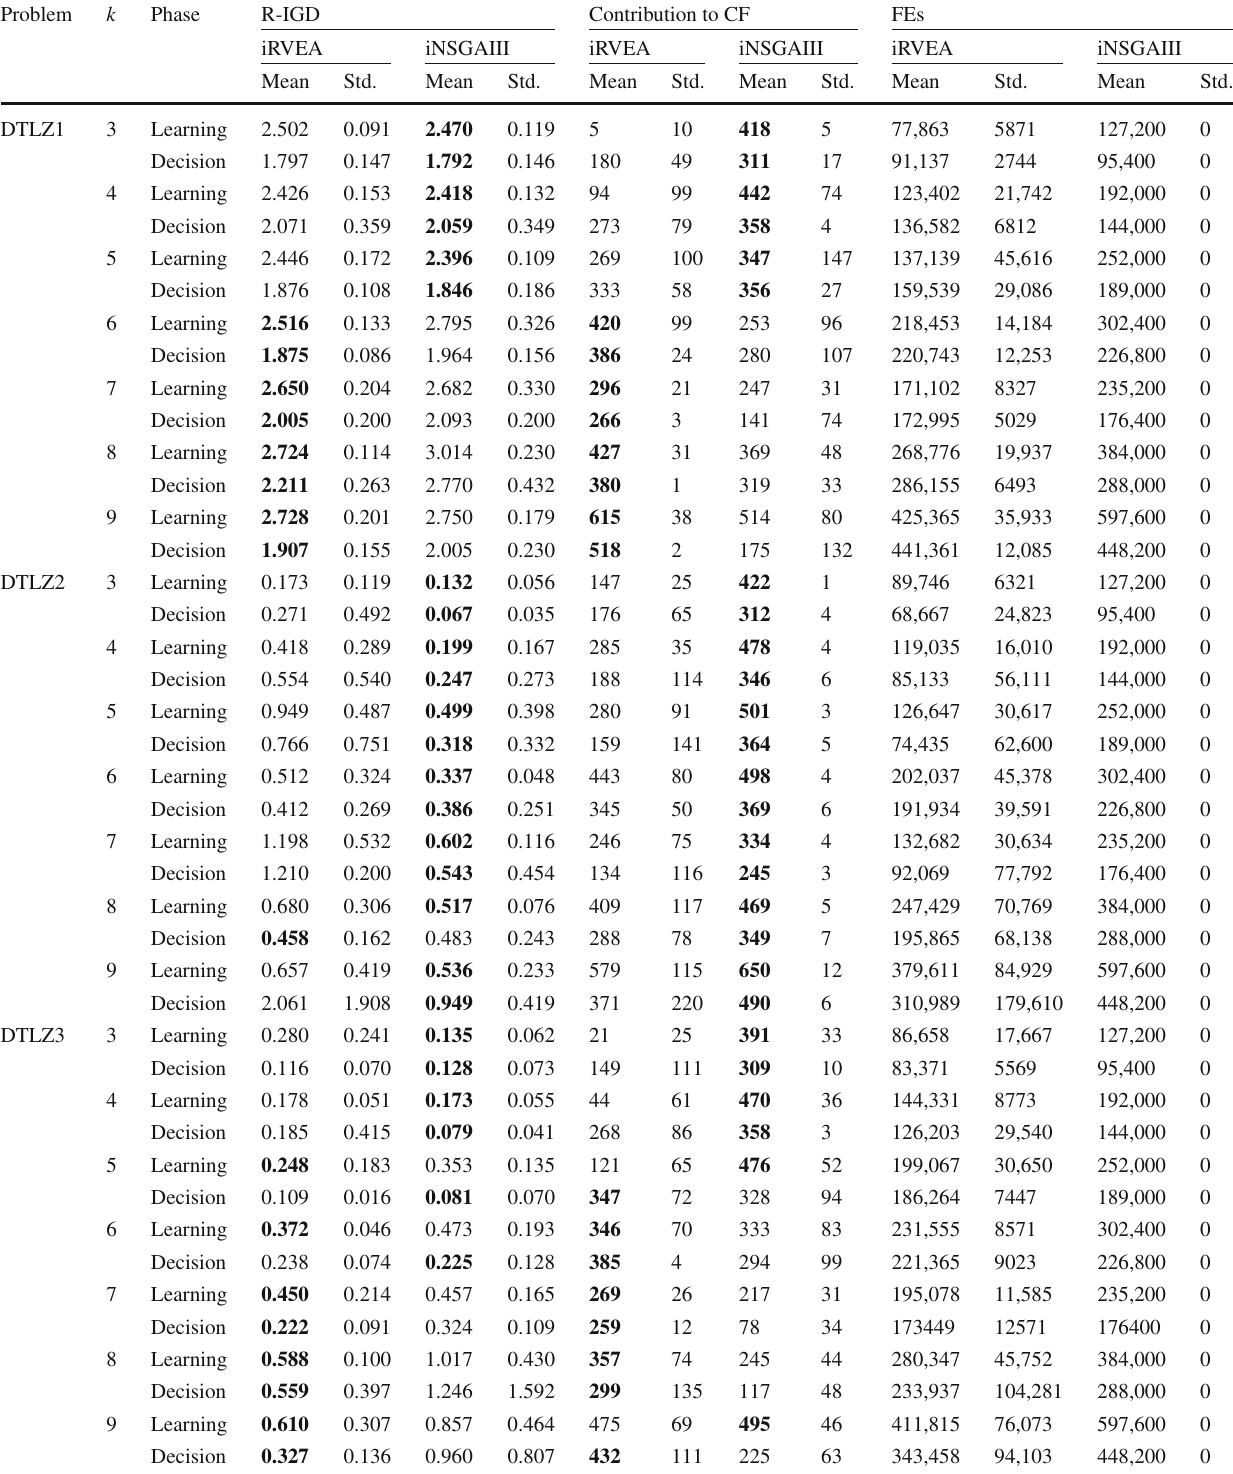
Table 3 iRVEA vs. iNSGAIII: numerical results with 100 generations per iteration for the objectives ranging from 3 to 9